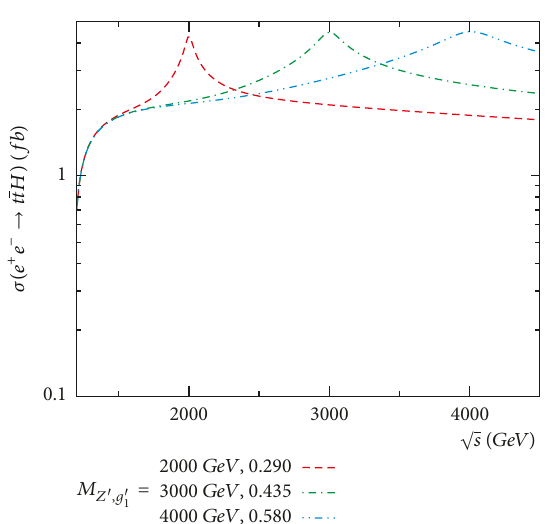
panel), and 𝜎 푇표푝 = 1, 2, 3, 4 𝑓𝑏 (bottom panel). The plots expose a strong correlation between 𝑀 푍 󸀠 and 𝑔 耠 1